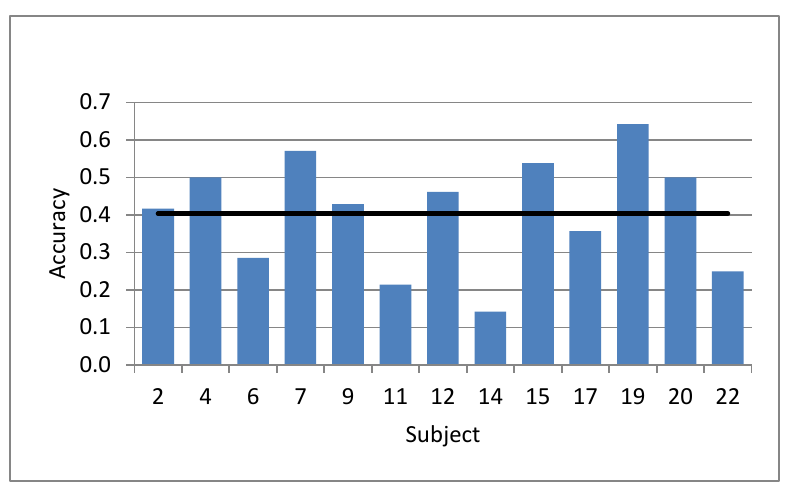
Figure 3. Perception accuracy in L3 German for obstruent devoicing at T1.